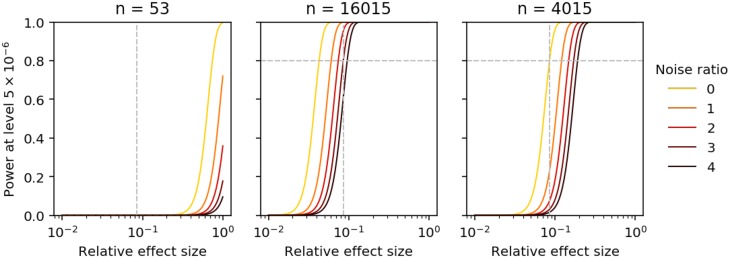
Power to detect dispersion QTLs.Power is a function of effect size (relative to phenotypic standard deviation), sample size, noise ratio, and significance level. Gray lines indicate the 99th percentile of dispersion effect sizes relative to the typical phenotypic standard deviation, and the power achieved to detect an effect of that size at the typical noise ratio. Power curves are computed for the current sample size (left), the sample size required to achieve 80% power for that effect size fixing the number of cells per individual (center), and the minimum sample size assuming no measurement error (right).